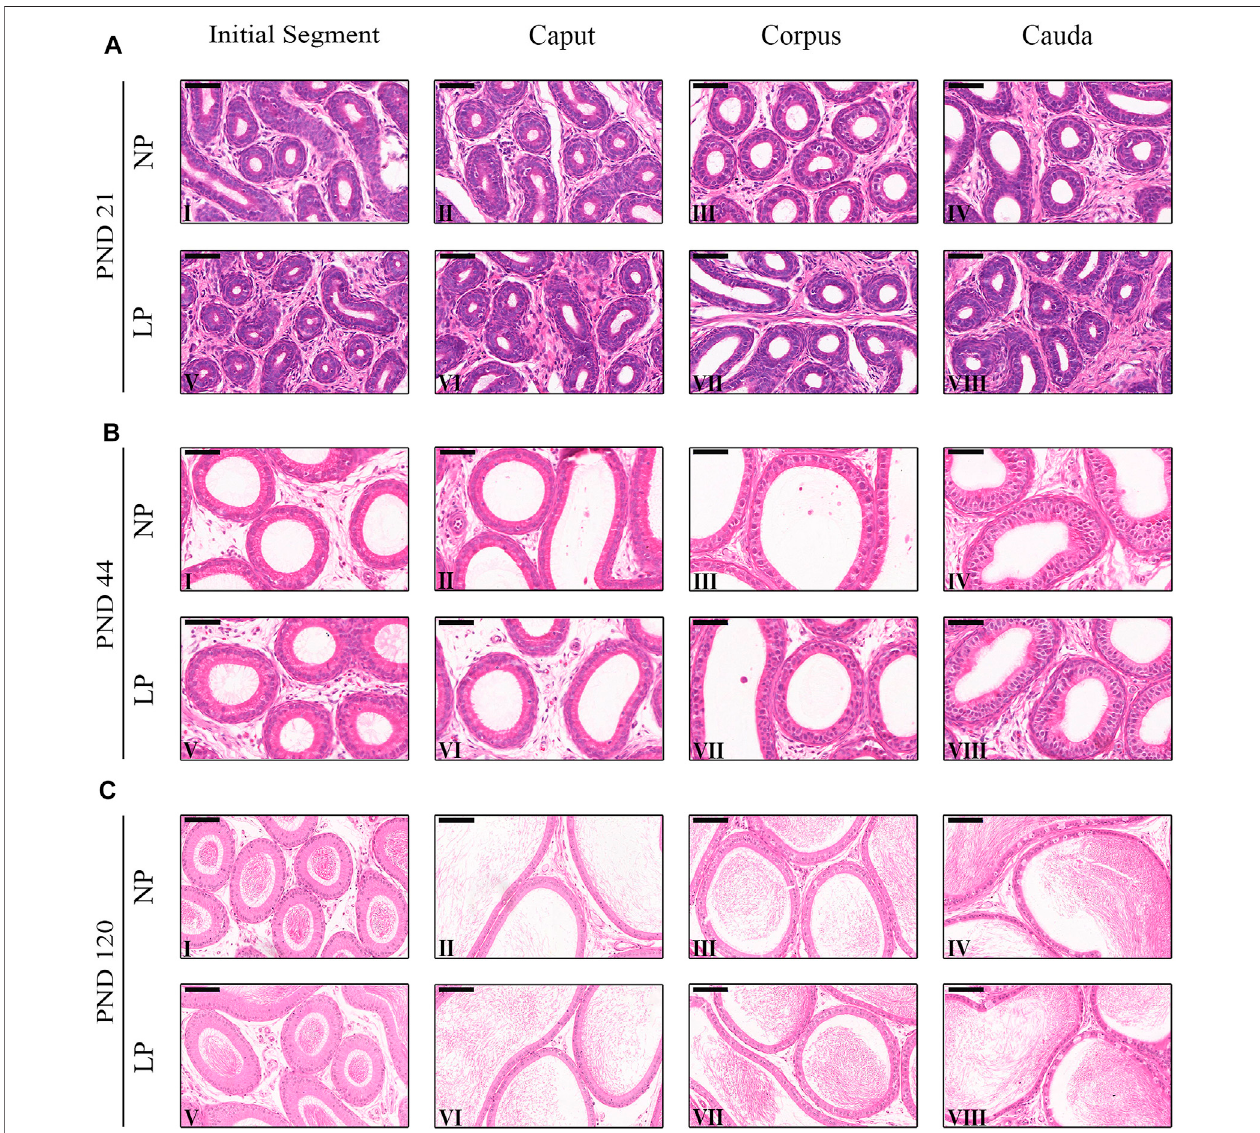
FIGURE 3 | Morphology ofthe epididymis. (A) Staining of the epididymidesof NP and LP animals at PND 21 showing the initial segment (Iand V) , caput (III and VI) , corpus (III and VII) and cauda (IV and VIII) . H&E, Bar = 50 µm. (B) Staining ofthe epididymidesofNPand LP animals at PND 44showing the initial segment (IandV) , caput (III and VI) , corpus (III and VII) and cauda (IV and VIII) . H&E, Bar = 50 µm. (C) Staining of the epididymides of NP and LP animals at PND 120 showing the initial segment (I and V) , caput (III and VI) , corpus (III and VII) and cauda (IV and VIII) . H&E, Bar = 100 µm.